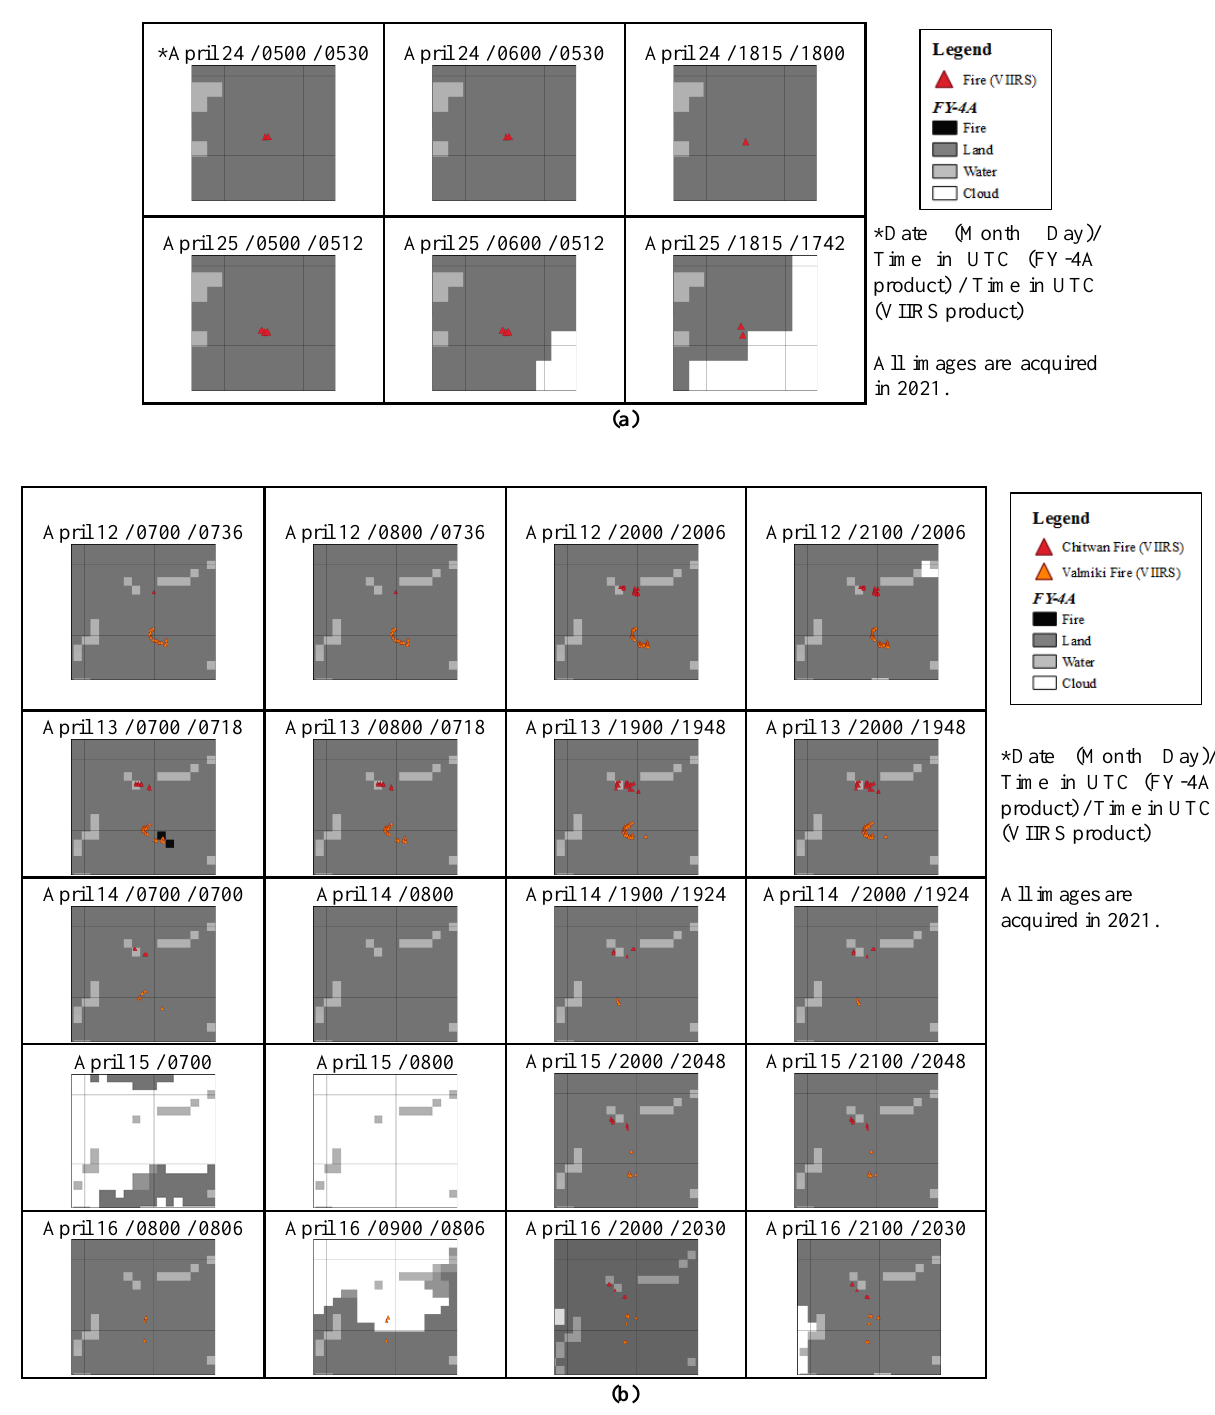
Figure 9. FY-4A and VIIRS fire detection products in (a) Benguet, Philippines; (b) West Chitwan, Nepal and Valmiki,